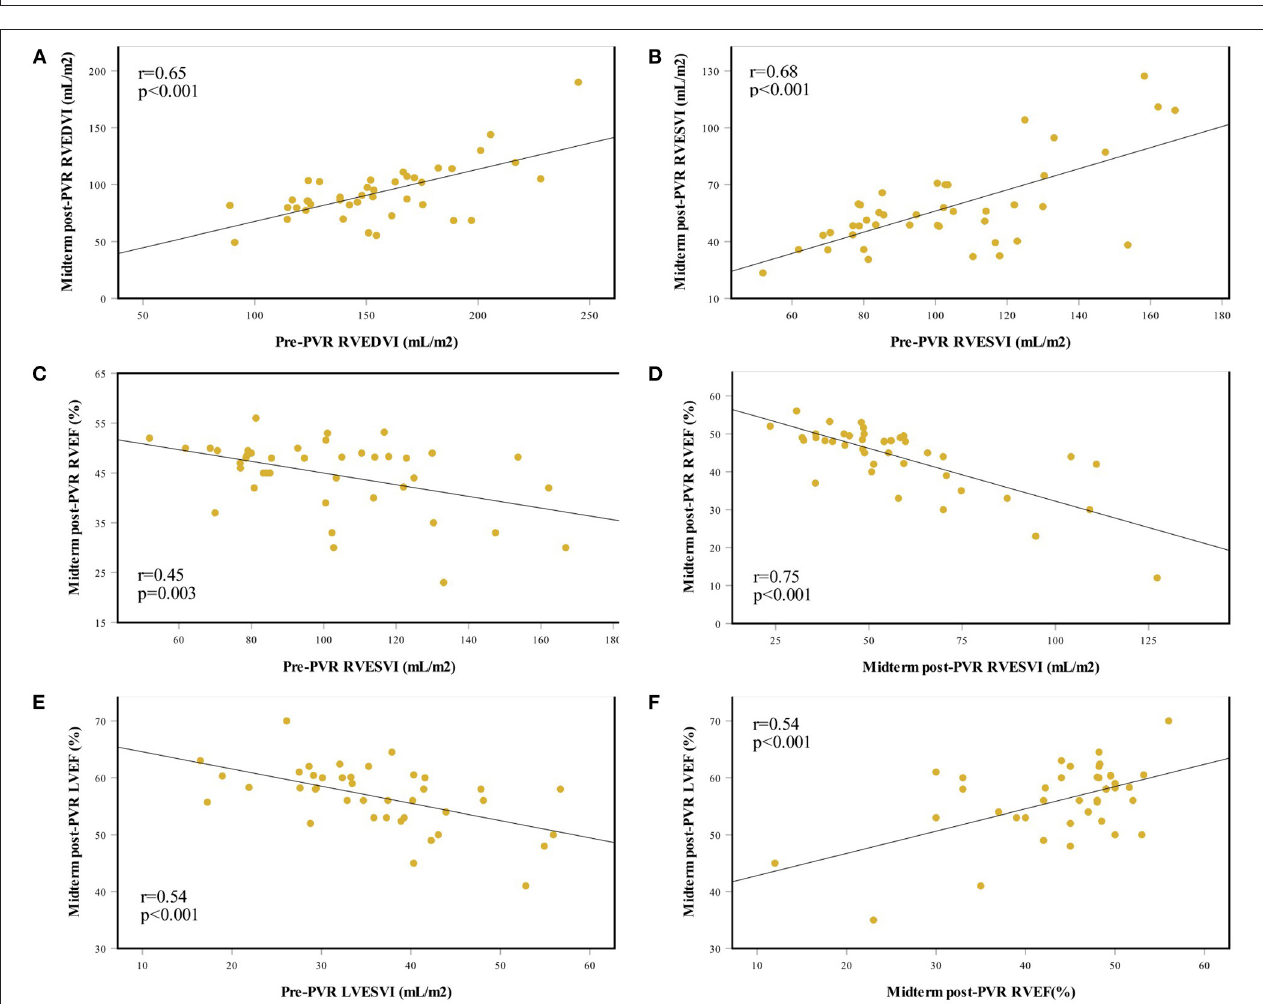
FIGURE 3 | Associations between pre-PVR and midterm post-PVR CMR parameters. (A) Association between pre-PVR and midterm post-PVR RVEDVI. (B) Association between pre-PVR and midterm post-PVR RVESVI. (C) Association between pre-PVR RVESVI and midterm post-PVR RVEF. (D) Association between midterm post-PVR RVESVI and RVEF. (E) Association between pre-PVR LVESVI and midterm post-PVR LVEF. (F) Association between midterm post-PVR RVEF and LVEF. CMR, cardiac magnetic resonance; LVESVI, left ventricular end-diastolic volume index; LVEF, left ventricular ejection fraction; PVR, pulmonary valve replacement; RVEDVI, right ventricular end-diastolic volume index; RVESVI, right ventricular end-systolic volume index; RVEF, right ventricular ejection fraction.